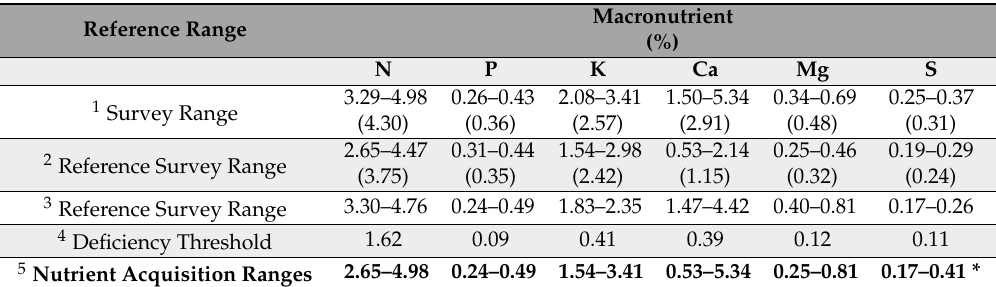
Table 2. Comparison of combined macronutrient concentration ranges and means for the thirteen greenhouse-propagated cannabidiol (CBD) hemp cultivars to reference survey ranges with additional reference to deficiency thresholds. Combined survey range values to indicate the minimum and maximum expanded nutrient acquisition ranges among all referenced